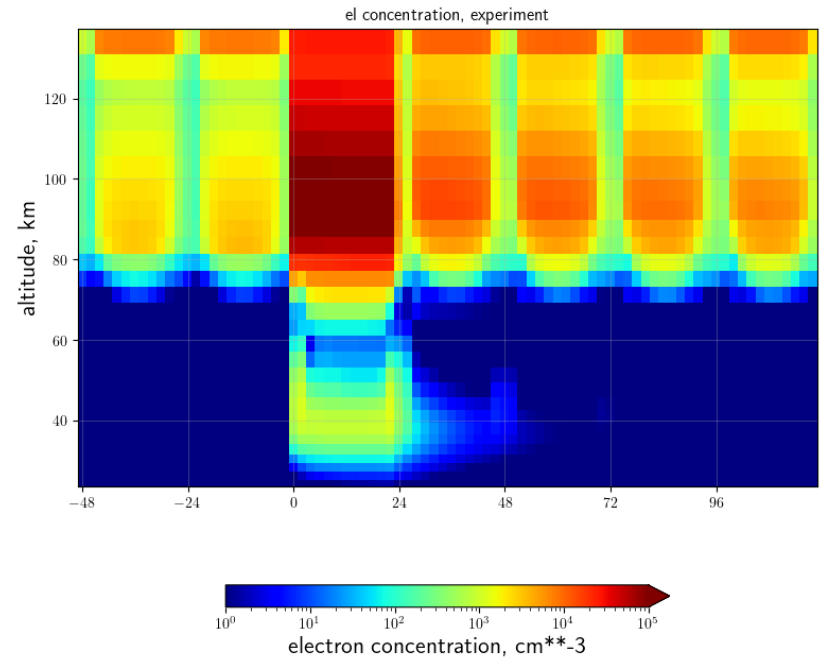
Figure 6. Simulation results of electron density before and after EEP on 28 September 1997.